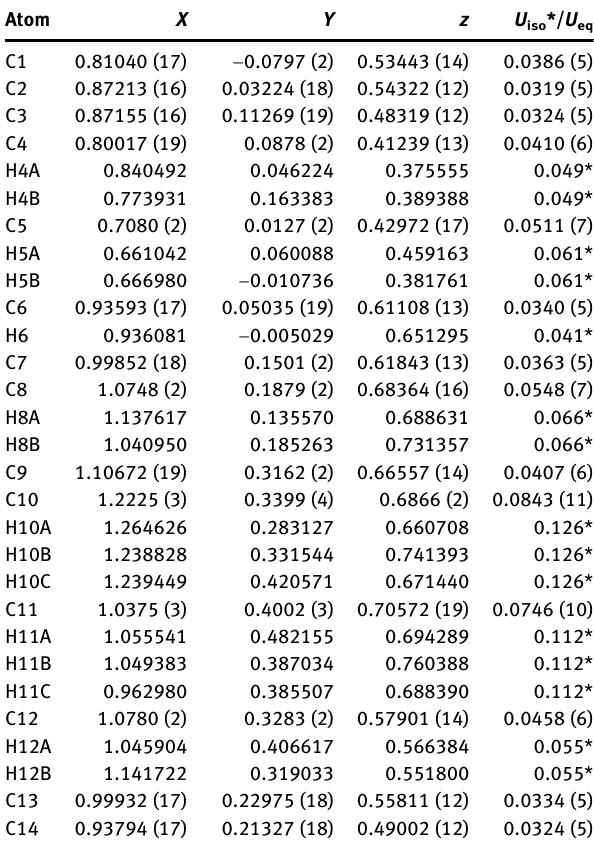
Table  : Fractional atomic coordinates and isotropic or equivalent isotropic displacement parameters (Å 